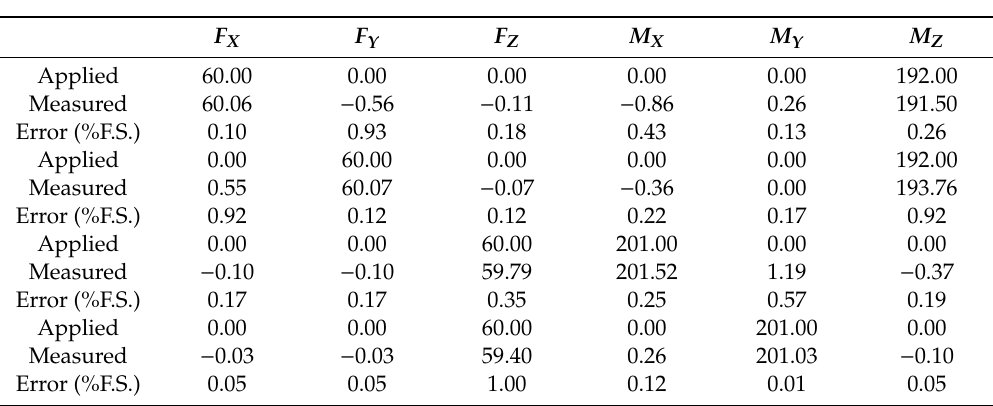
Table 4. Calculated and real values when forces / torques are applied on traction force